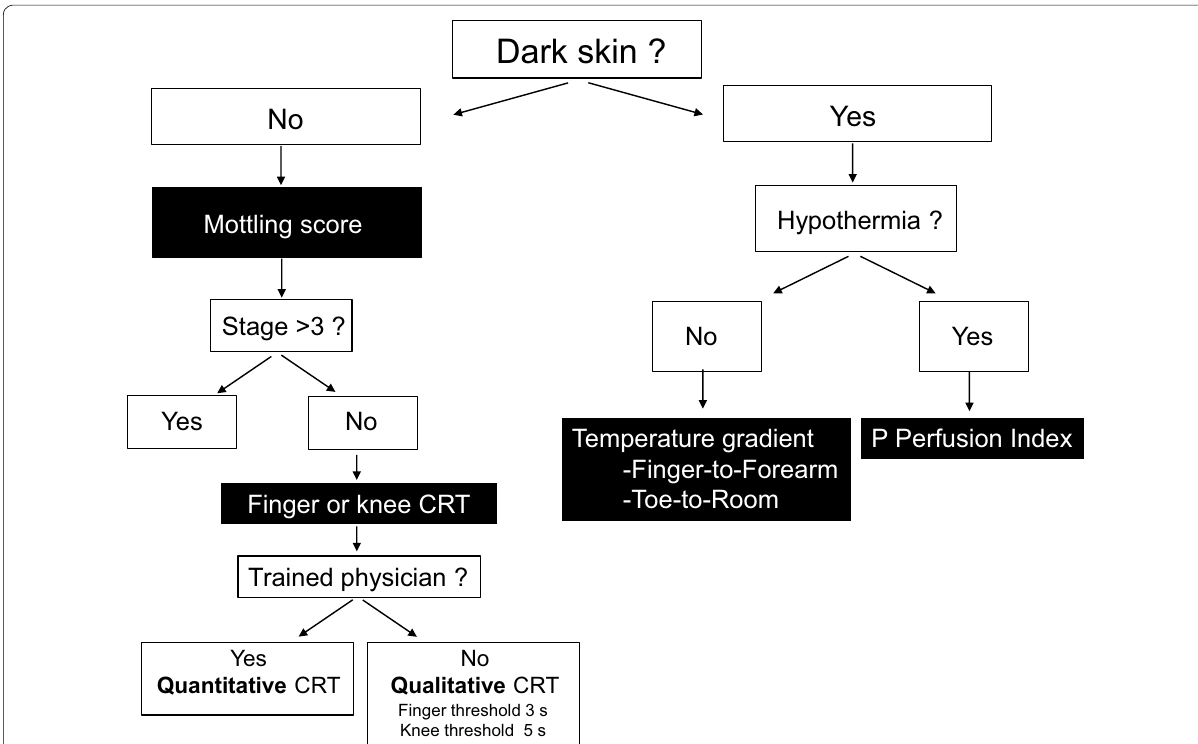
Fig. 3 Proposed strategy to evaluate peripheral tissue perfusion using the skin. CRT capillary refill time, P.Perfusion index peripheral perfusion